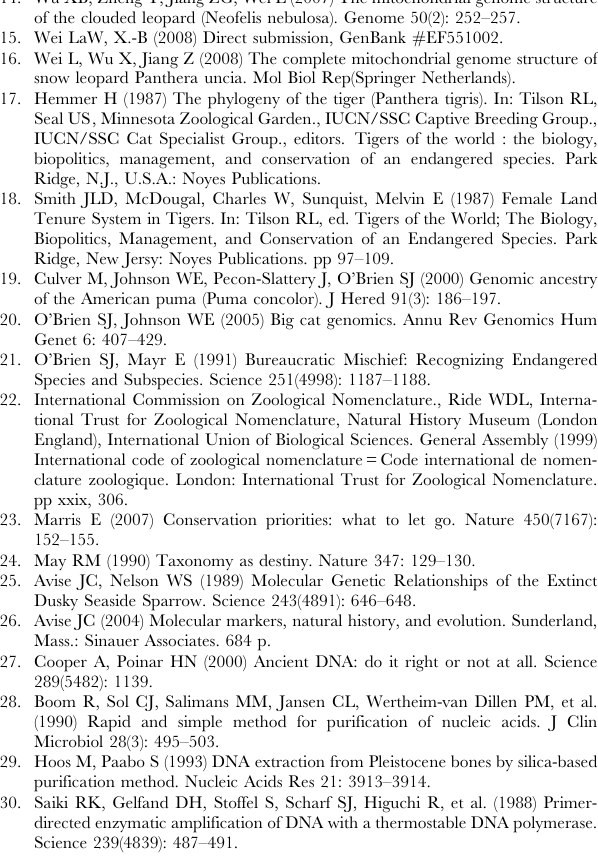
Table S3 Variable sites among tigers in an alignment of 4 kb of concatenated mtDNA sequences used in phylogenetic